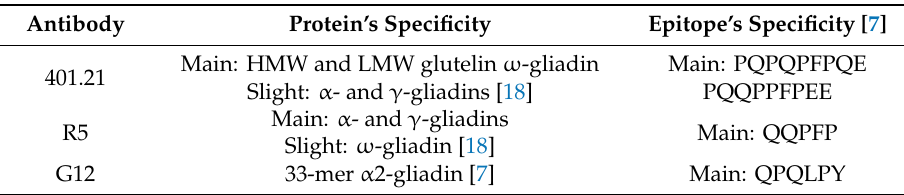
Table 1. Commercial antibodies specificity to